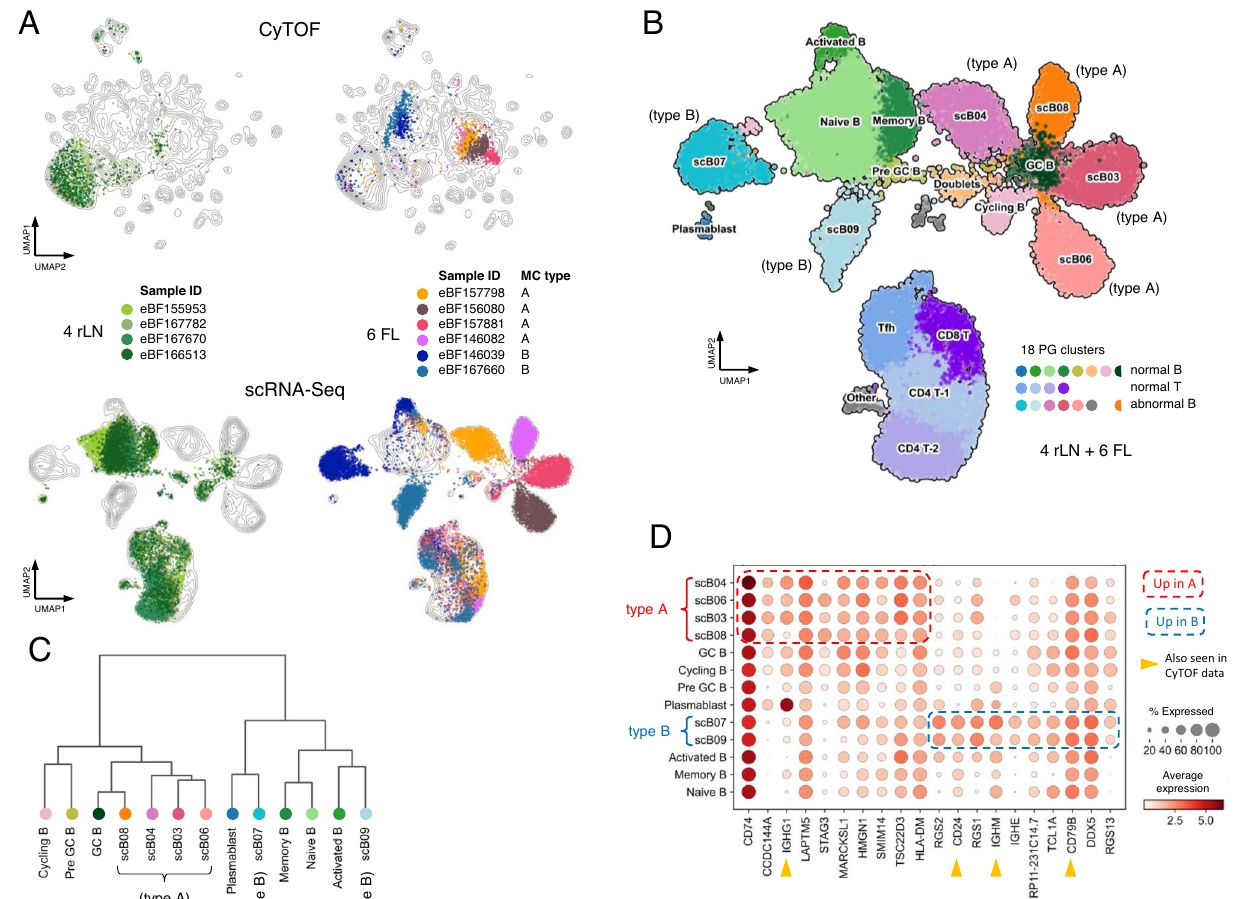
Fig. 2 | Single-cell RNA-seq recapitulates CyTOF-de fi ned FL subtypes. A Parallel analysisbyCyTOFandscRNA-seq.UpperpanelsshowUMAPplotsofCyTOFdataas in Fig. 1A. Lower panels show UMAP plots of scRNA-seq data for the same set of samples. Each dot represents a single cell. Dots are colored by patient sample. Contour lines show density in the combined rLN + FL datasets. The indicated MC typeswerede fi nedbyCyTOF. B UMAPplotofscRNA-seqdataasinlowerpanelsof A but merging all 10 samples into the same plot. Dots are colored by their assignment into one of 18 scRNA-seq clusters. Normal B- and T-cell clusters were manually annotated based on expression of reference marker RNAs. scB clusters were unique to FL samples. Cells in the GC B cluster were assigned to the same clusterasscB08butderivefromrLNsamplesandarelabeledseparatelyforclarity.